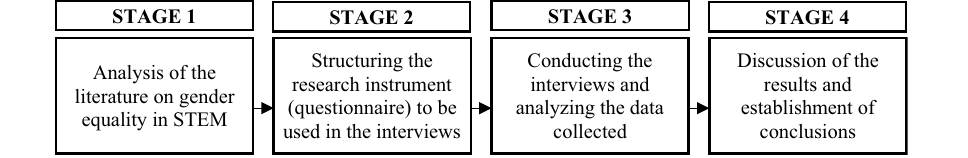
Fig. 1 Research stages